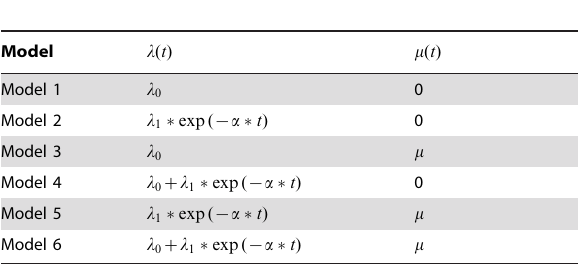
Table 1. The six different birth-death models with the corresponding